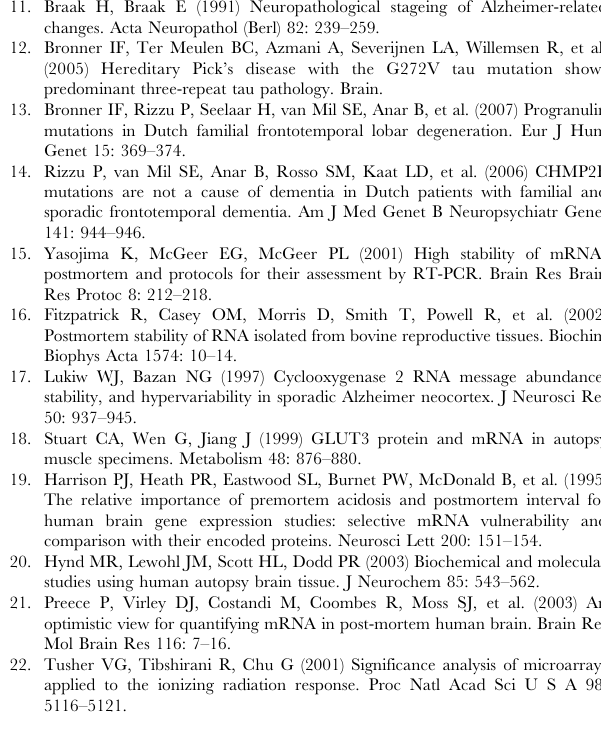
Table S4 Overview of detected probes, signal strengths, background and noise levels.